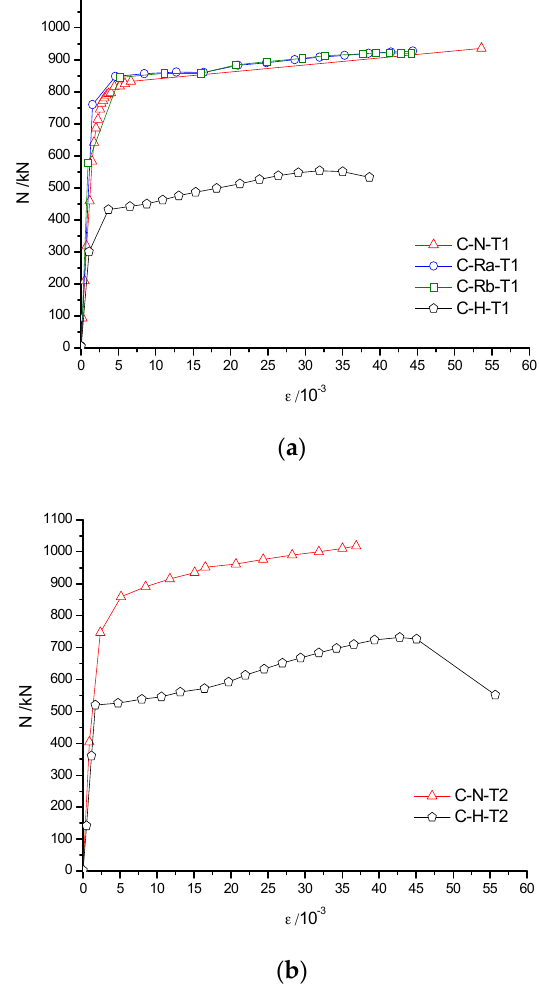
Figure 13. Influence of concrete materials on N- ε curves. ( a ) The wall thickness of steel tube is 4 mm; ( b ) The wall thickness of steel tube is 5 mm.